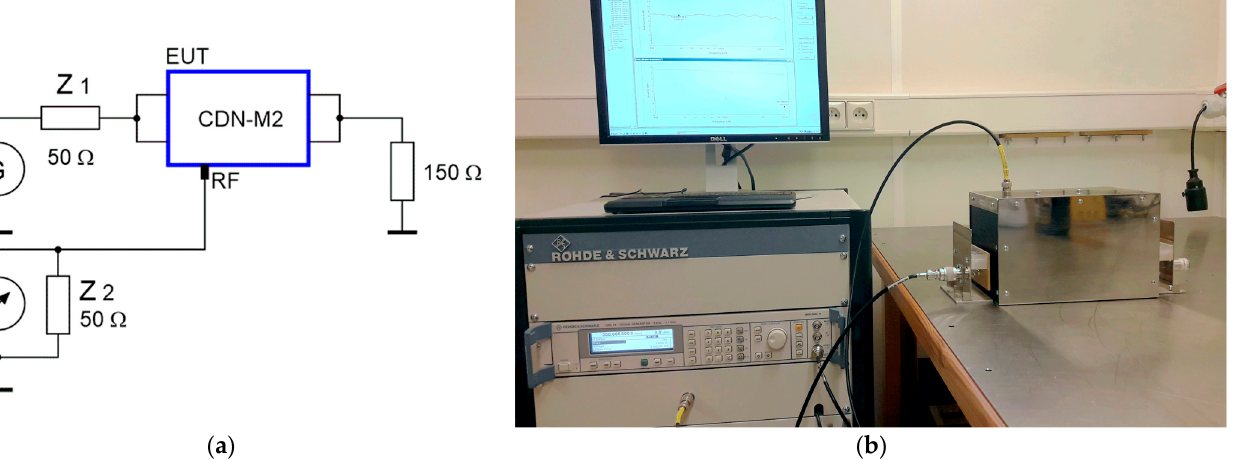
Figure 4. CDN-M2 network voltage division ratio measurement stand. ( a ) Electrical diagram and ( b ) photograph of the stand.